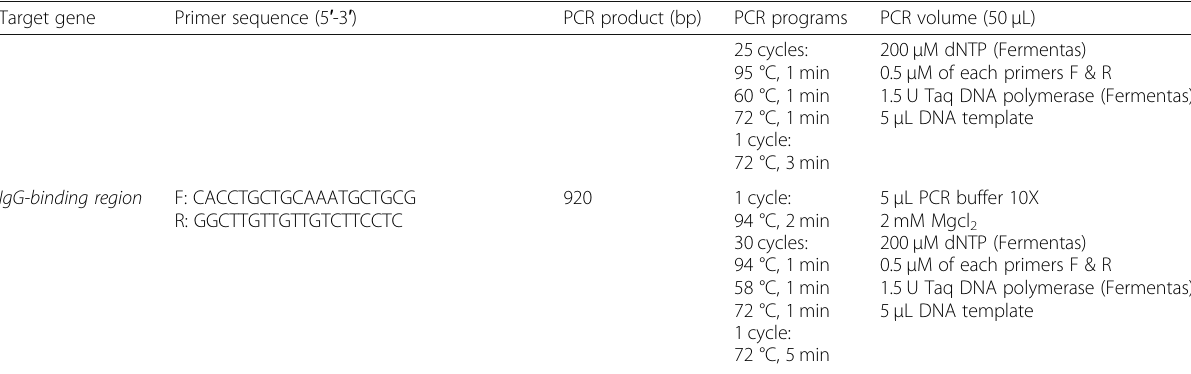
Table 4 Target genes, oligonucleotide primers, and PCR conditions used for the detection of virulence factors and antibiotic resistance genes in the S. epidermidis strains isolated from various types of hospital infectious samples (Continued) Target